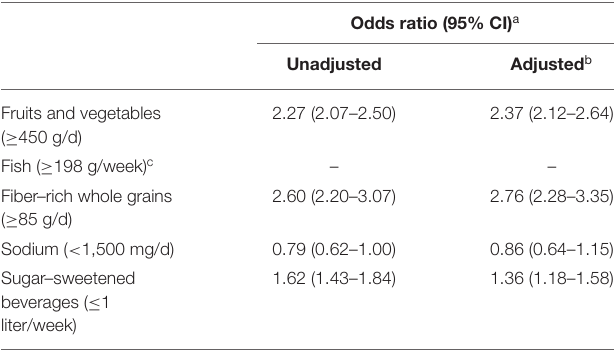
TABLE 3 | The odds ratio for healthy diet score between vegetarian and